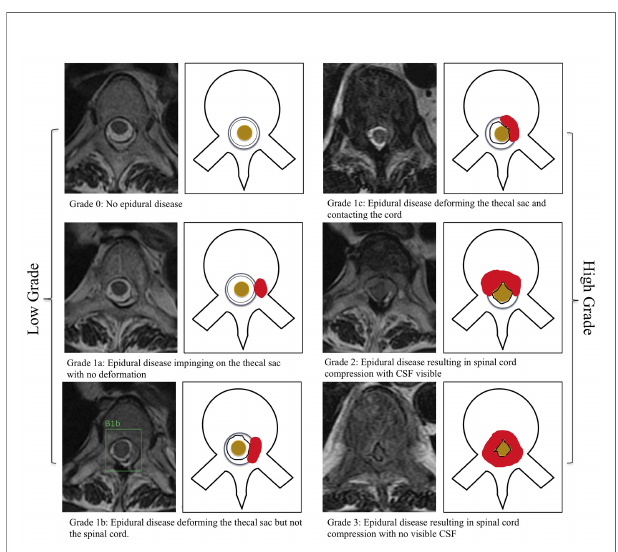
FIGURE 1 | Bilsky classi fi cation of metastatic epidural spinal cord compression on MRI of the thoracic spine. Axial T2-weighted (repetition time ms/echo time ms, 5,300/100) images were used. Training of the deep learning model was performed by a radiologist by placing a bounding box around the region of interest at each T2-weighted image. A bounding box example is included for a low-grade Bilsky 1b lesion (1b). CSF, cerebrospinal fl